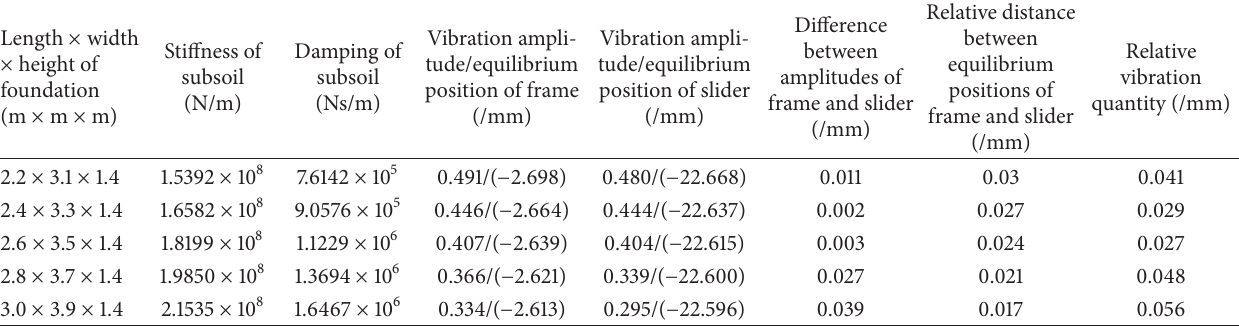
Length × width × height of foundation (m × m × m)